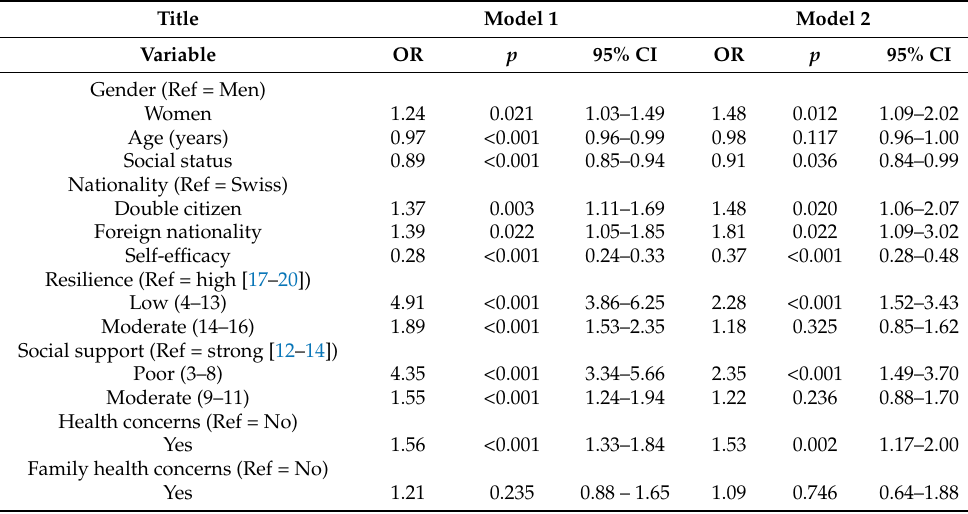
Table 3. Factors associated with depressive symptoms among university